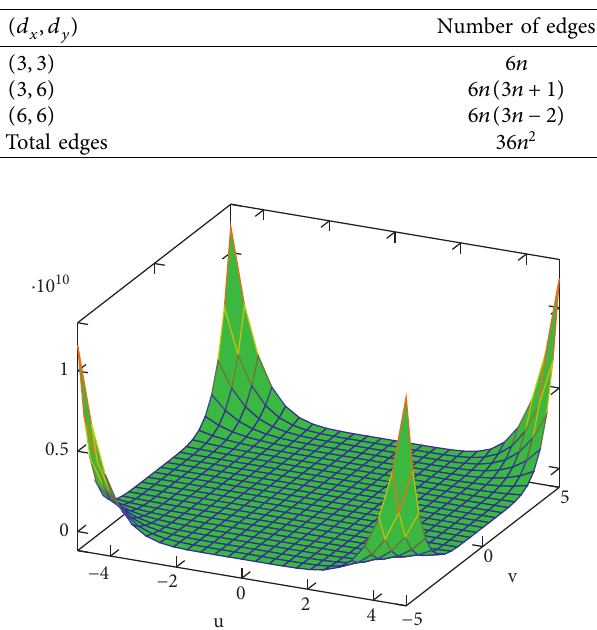
Figure 2: Visual representation of M-polynomial of silicate net- work ( SL n ) for n �